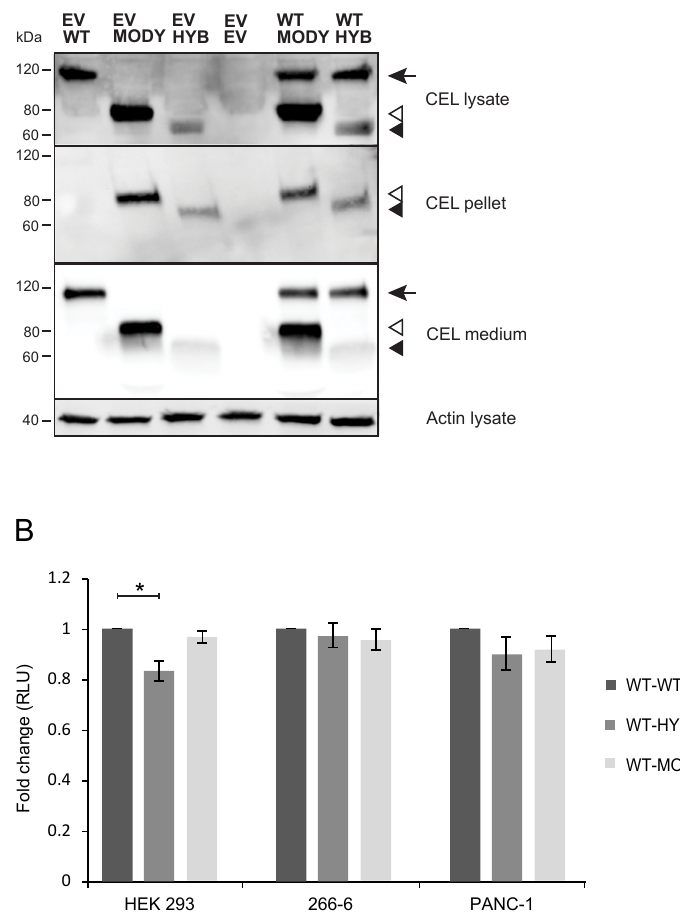
Figure 8. The e ff ect of coendocytosis of secreted CEL protein variants on cell viability. ( A ): Untransfected 266-6 cells were cultured for 24 h in a 1:1 mixture of conditioned medium from two di ff erent HEK293 cell lines stably expressing either CEL-WT, CEL-MODY, CEL-HYB, or EV in the combination indicated on top of the figure. The medium, lysate, and pellet fractions were analyzed by western blotting using an anti-V5 tag-specific antibody. Actin in the lysate fraction was used as loading control. The arrow indicates the position of CEL-WT, open arrowhead shows CEL-MODY, and filled arrowhead CEL-HYB. The experiment was repeated three times with similar results, and one representative image is shown. ( B ): HEK293, 266-6, and PANC-1 cells were grown for seven days in the presence of conditioned medium containing CEL-WT-FLAG and either CEL-WT, CEL-HYB, or CEL-MODY. Cell viability was measured as intracellular ATP content. The experiment was repeated four times for each cell line, with 7–12 parallels per condition. Data are shown as mean values, the error bars representing SEM (n = 4). * denotes p < 0.05 when compared with CEL WT-FLAG coendocytosed with CEL-WT-V5. RLU, relative light